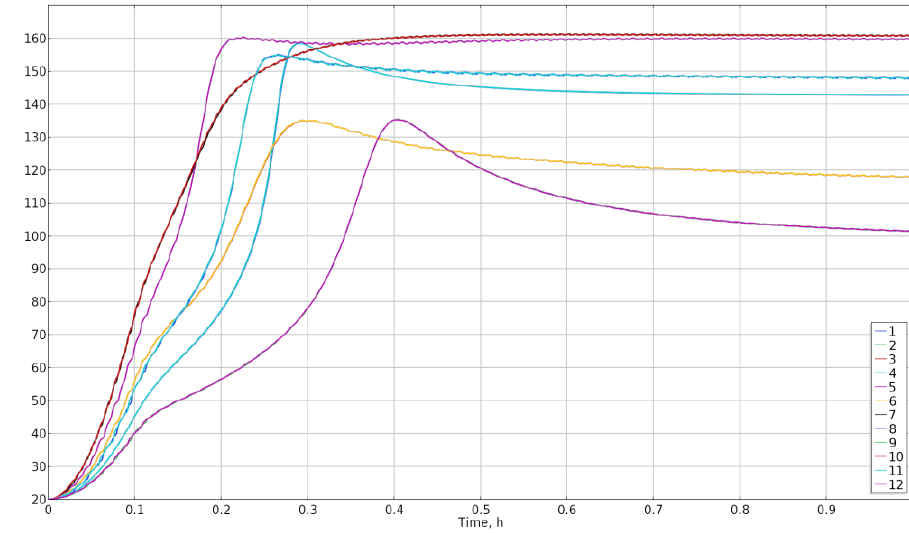
Fig. 6. The dynamics of temperature changes at control points of the workpiece, ℃ . Legend corresponds to fig.